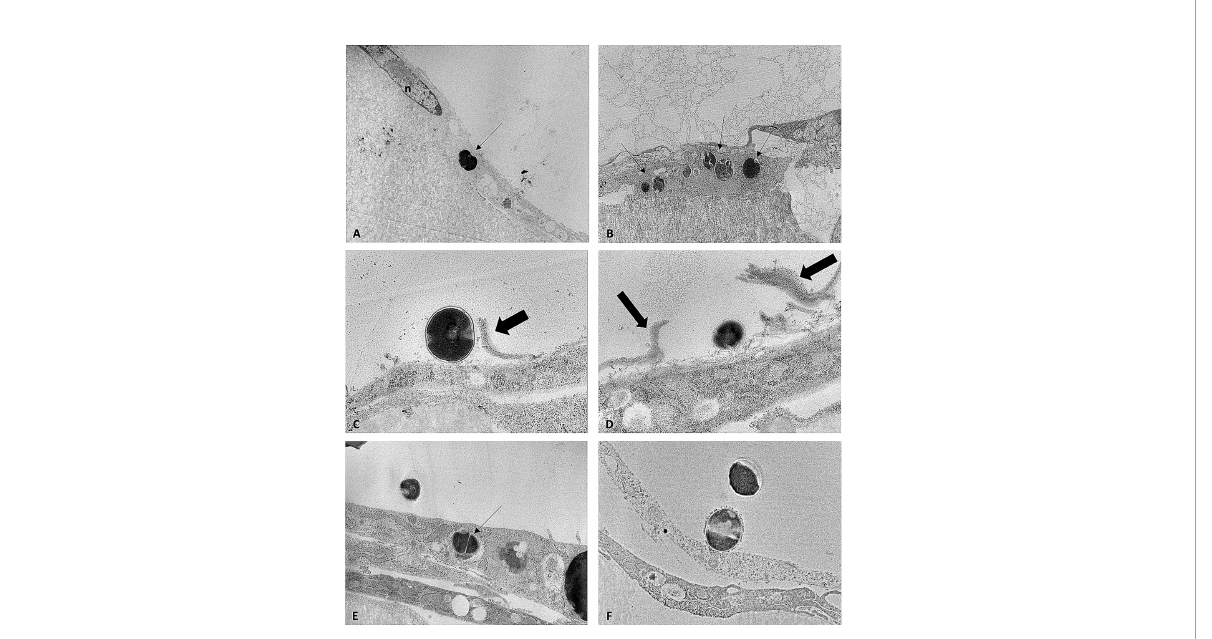
FIGURE 3 TEM images obtained from MC3T3-E1 cells infected with SA Cowan1 (A) , USA300 (B – D) , and ST398 (E, F) . (A) : single intracellular Cowan1 organism (black arrow), distorted in shape. (B) : one osteoblastic cell infected with multiple USA300 organisms (black arrows). (C, D) : USA300 organisms bordering osteoblastic cells. Thick black arrows denote discontinuous cellular membranous material which may indicate incorporation of USA300 into the cell by fi lipodia or may indicate disrupted cellular membranes. (E) : one intracellular and one extracellular ST398 organism. (F) : extracellular ST398 organisms. One ST398 bordering an osteoblastic cell, surrounded by a halo of membranous material. Scale bar = 0.7 m